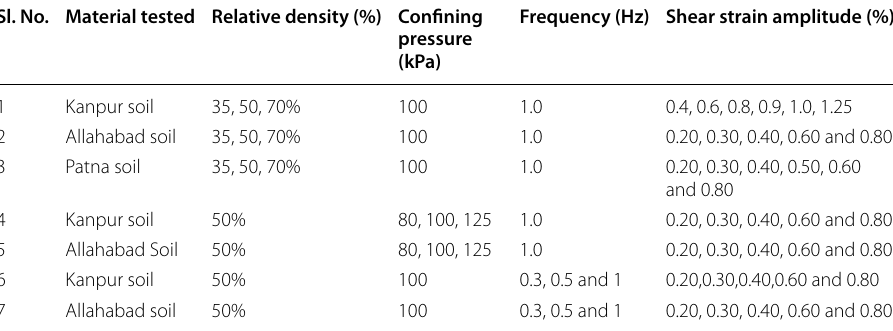
Table 2 Program adopted for the cyclic triaxial testing Sl. No. Material tested Relative density (%) Confining